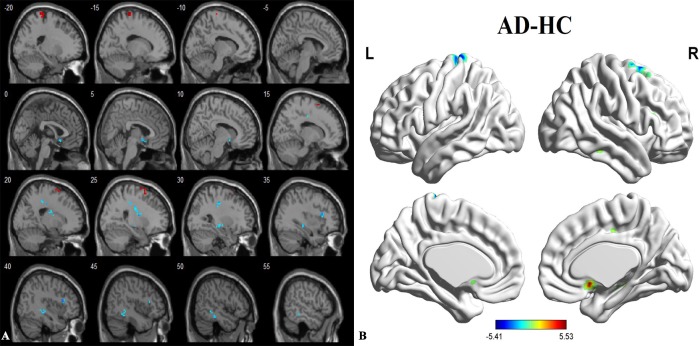
(A and B). Between-group differences in AD and HC before acupuncture, based on a 2-sample t test with age, gender, education level and mean FDR as covariates. The threshold was set to P < 0.001 with topo FDR corrected. The color scale represents t values. Cold color represents decreased ALFF in AD patients compared to HC. AD, Alzheimer’s disease; HC, healthy control; ALFF, amplitude of low-frequency fluctuations.